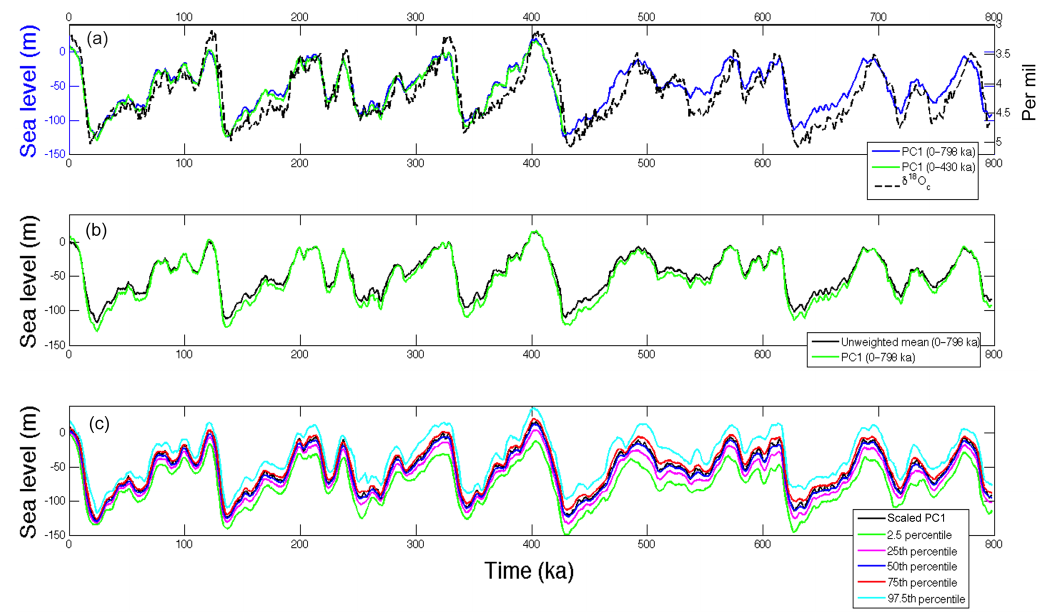
Figure 2. (a) Long and short sea level stacks compared to the LR04 benthic δ 18 O c stack (Lisiecki and Raymo, 2005). (b) Scaled PC1 compared to unweighted mean of individual records. Scaled PC1 is comprised of short PC1 (0–431ka) pasted to long PC1 (431–798ka). (c) Scaled PC1 compared with percentile levels from the bootstrap results, which are also plotted as a composite of the short (0–431ka) and long (431–798ka) time